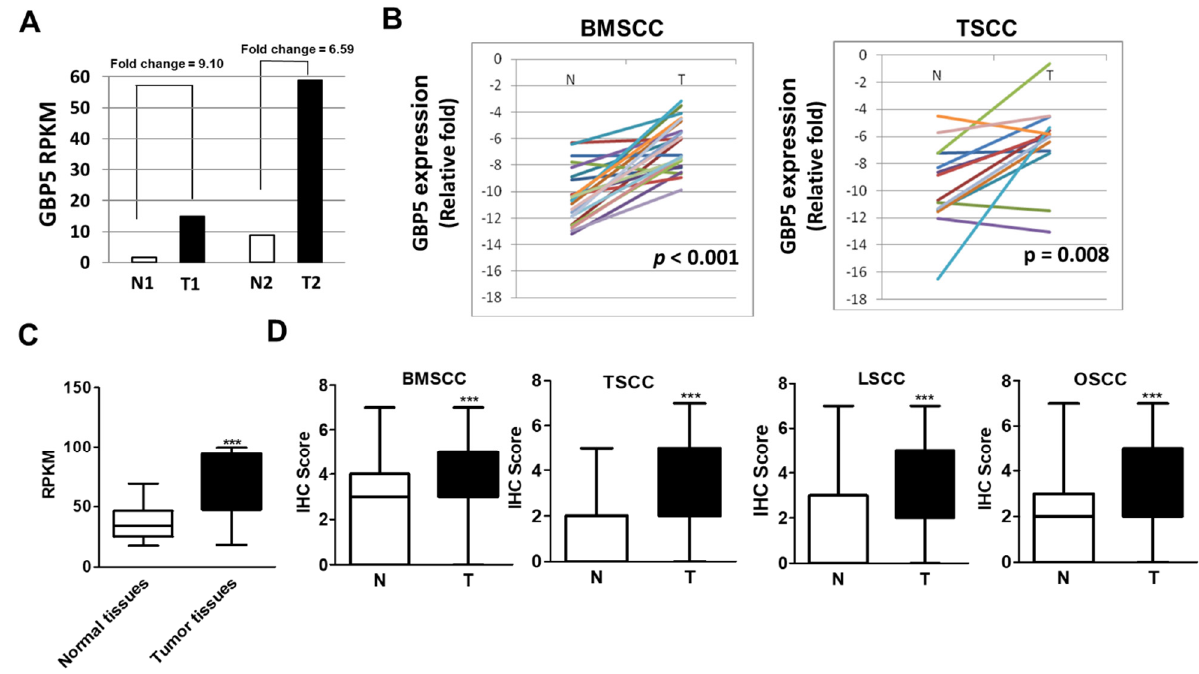
Figure 1. Comparison of GBP5 expression between tumor and adjacent normal tissues in oral cancer patients. ( A ) Relative fold-changes of GBP5 RPKM in CTAN tissues and tumor tissues in two paired OSCC patients by NGS. ( B ) Comparison of GBP5 gene expression between tumor tissues and CTAN tissues from 23 paired BMSCC and 14 paired TSCC patients by RT–PCR. ( C ) RPKM values of GBP5 between 29 normal tissues and 303 tumor tissues in oral cancer patients from TCGA based RNA seq. ( D ) GBP5 IHC scores in CTAN tissues and tumor tissues: 182 BMSCC, 245 TSCC, and 72 LSCC. Data on the whole cohort of 499 patients are also shown (N: CTAN tissues; T: tumor tissues). A value of p < 0.05 was considered significant (*** p < 0.001).